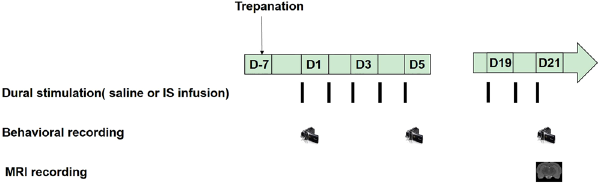
Figure 1. Schematic of the experimental design. About 1 week after surgery, the rats received daily inflammatory soup (IS) or saline infusion. Nociceptive behaviors were recorded once every 4 days in both groups before and after infusion. Magnetic resonance imaging (MRI) recordings were performed on day